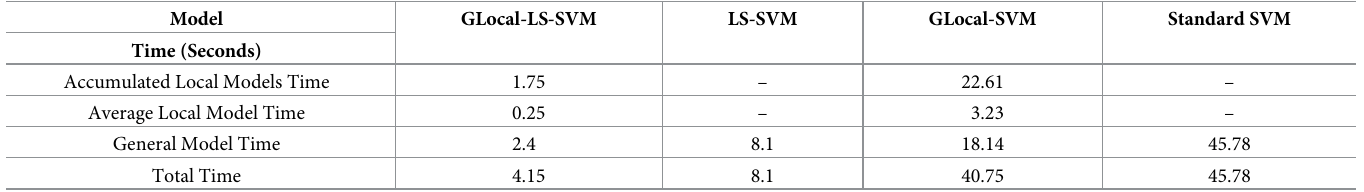
Table 6. Comparing the average time performance, in seconds, of the GLocal-LS-SVM model to the global LS-SVM model, Glocal-SVM, and standard SVM applied to the breast cancer Wisconsin (diagnostic) dataset.